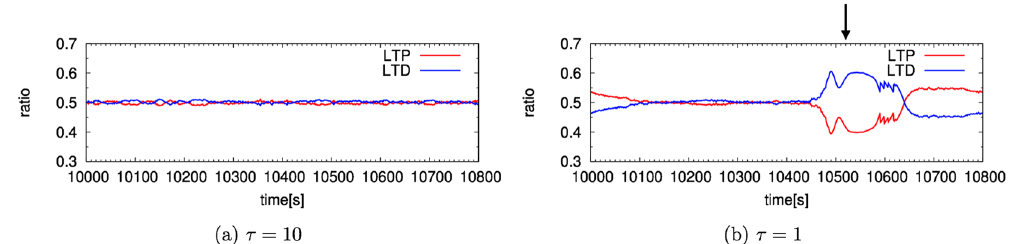
Figure 7. Temporal change in the ratio of amount of LTP and LTD. The change when (a) τ = 10 and (b) τ = 1. The arrow corresponds to the peak of firing rates shown in Fig. 4(a). The horizontal axis represents time [s]. The vertical axis represents the ratio of LTP and LTD.